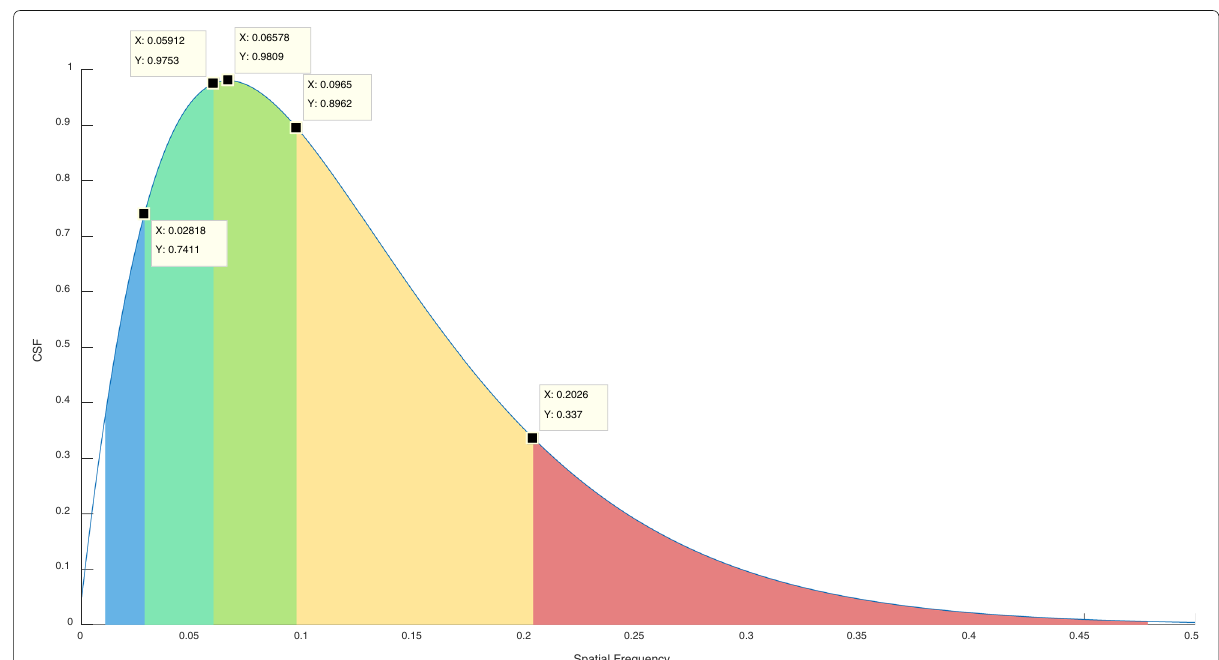
Fig. 4 The visual CSF characteristic curve. The CSF curve is divided into five segments, which correspond to red, orange, green, cyan, and blue colors